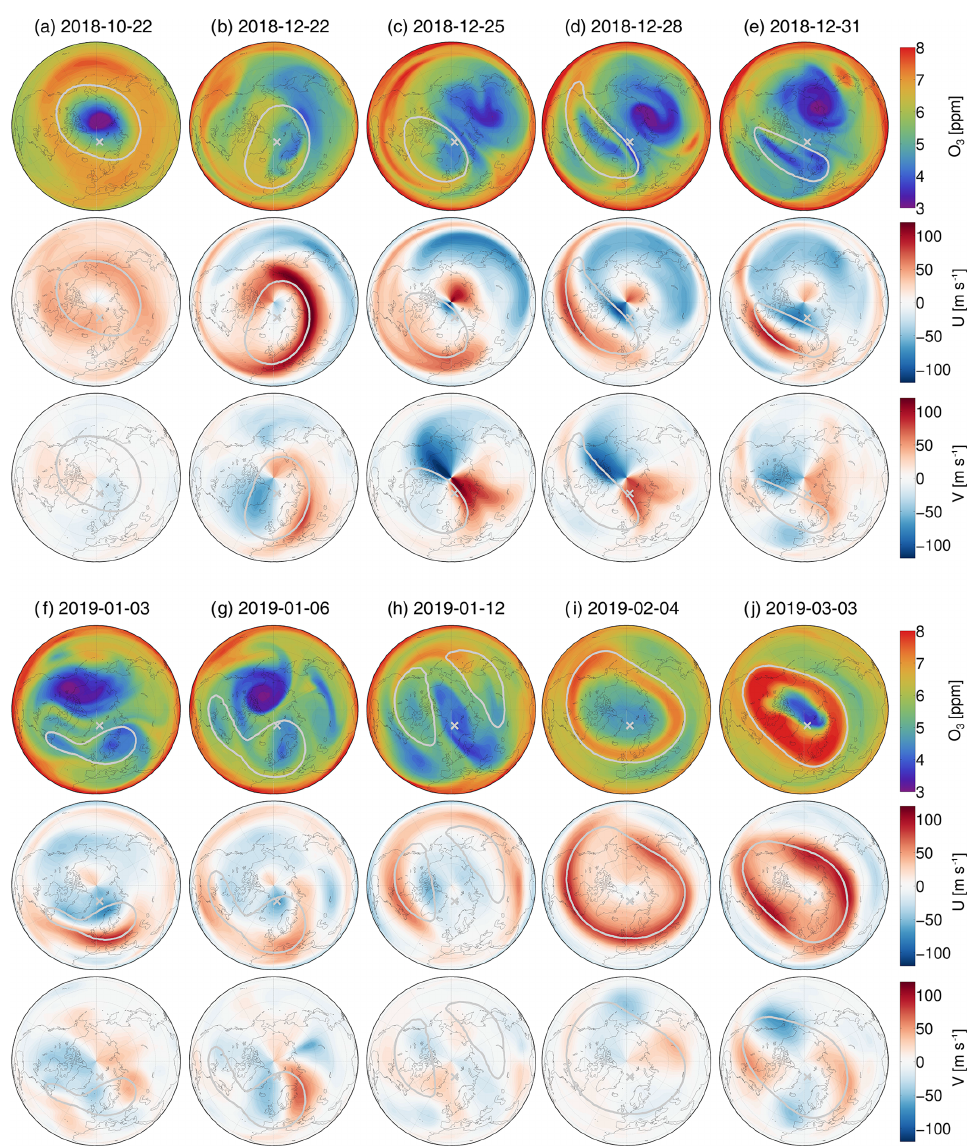
Figure 12. SD-WACCM ozone VMR, zonal wind and meridional wind at 3hPa. The edge of the polar vortex and the location of Ny-Ålesund are indicated in grey. The dates correspond to the polar vortex snapshots in Fig.